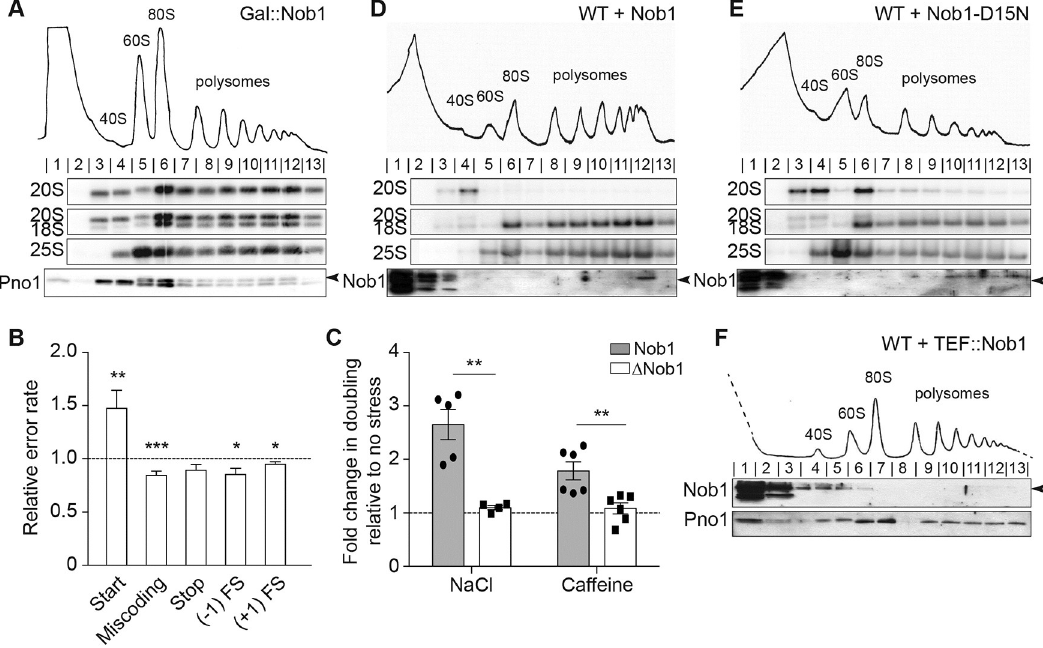
Fig 1. Nob1 prevents entry of pre-40S subunits into the polysomes. (A) Shown are 10%–50% sucrose gradients from lysates of cells depleted of Nob1 by growth in glucose for 12 h. Shown below the absorbance profile at 254 nm are northern blots of pre-18S rRNA (20S), mature 18S, and 25S rRNAs and western blots probing for Pno1. Arrowhead notes the upper band corresponding to Pno1. (B) The effects from depletion of Nob1 on the fidelity of start codon recognition, decoding, stop codon recognition, and FS ( − 1 and +1) were assayed using dual-luciferase reporters. Shown are the relative error rates of the glucose-depleted samples relative to replete samples. Data are the averages of 10 − 27 biological replicates, and error bars indicate the SEM. � p < 0.05, �� p < 0.01, ��� p < 0.001 by unpaired t test. (C) Changes in doubling time in cells replete (Nob1) or depleted ( Δ Nob1) for Nob1 after exposure to high salt (1 M NaCl) or caffeine (10 mM). Values were compared to no-stress conditions (fold change = 1). Data are the averages of six (caffeine) or four to five (high salt) biological replicates, and error bars indicate SEM. �� p < 0.01 by unpaired t test. Numerical data are listed in S1 Data. (D, E) Sucrose gradients of wild-type BY4741 cells overexpressing Nob1 (D) or Nob1-D15N (E) under the galactose-inducible, glucose-repressible Gal promoter in galactose for 12 h. Western blots probed for Nob1. Arrowhead notes the upper band corresponding to Nob1. (F) Sucrose gradients of WT BY4741 cells overexpressing Nob1 under the constitutive Tef2 promoter grown in glucose. See also S1 Fig. FS, frameshifting; Gal, galactose; WT, wild-type.